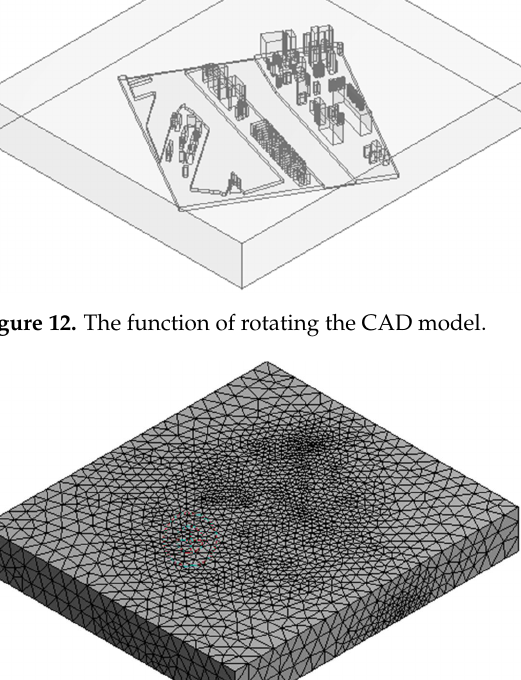
Figure 13. The effect of model discretization—computational grid.